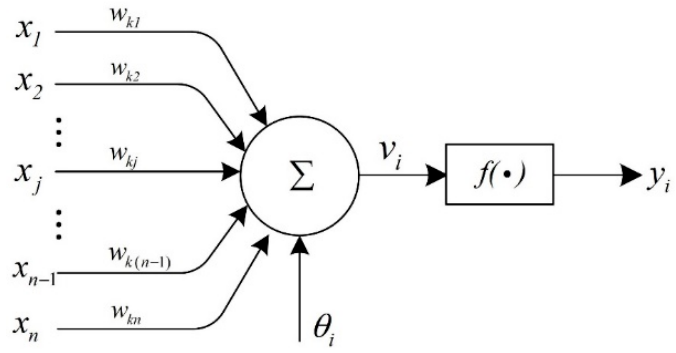
Figure 7. Single neuron structure.